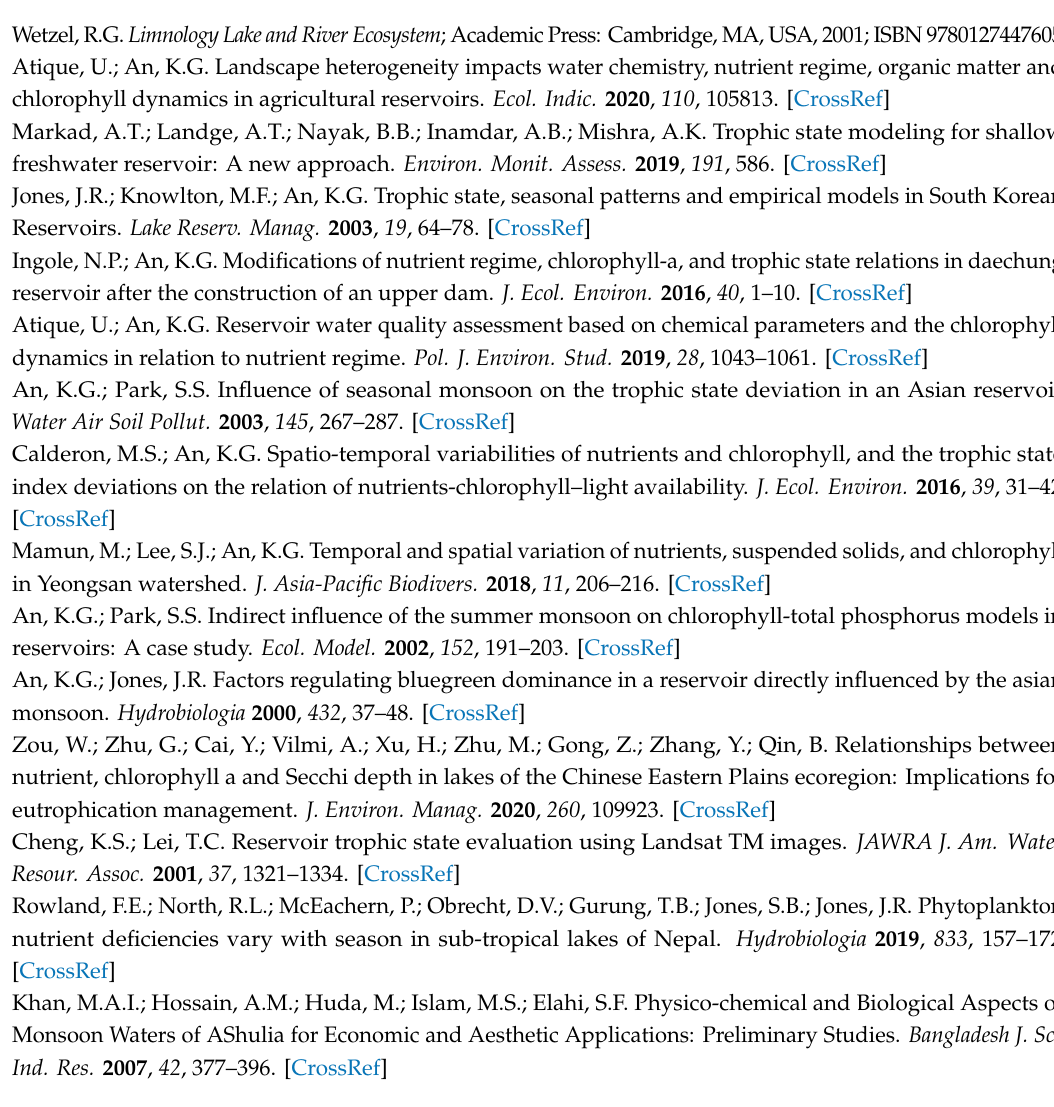
Figure S1: Annual variation of chemical water quality parameters in Daecheong Reservoir from 2000–2018. TP: total phosphorus; TN: total nitrogen; EC: electrical conductivity; BOD: biological oxygen demand; COD: chemical oxygen demand; TSS: total suspended solids; CHL-a: chlorophyll-a; and TPR: total precipitation; red lines in the box indicate the mean value. Figure S2: Monthly variation (2000–2018) of physicochemical parameters in embankment (S4 and S6) and mainstem (S3 and S5) of Daecheong Reservoir (TP: total phosphorus, TN: total nitrogen, CHL-a: chlorophyll-a, SD: Secchi depth, and I–XII: January–December). Figure S3: The relationship between CHL-a and TP is plotted conditional on the range of TN. Figure S4: The relationship between CHL-a and TN is plotted conditional on the range of